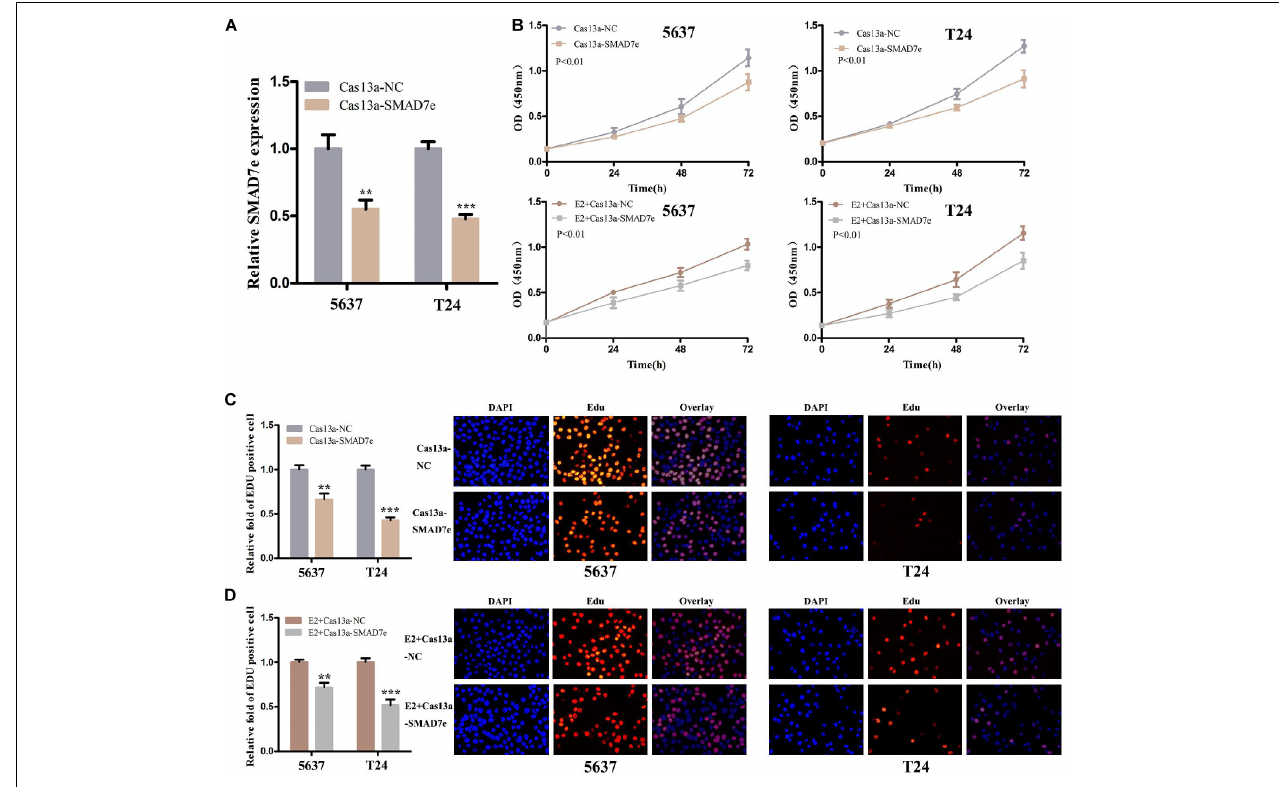
FIGURE 3 | The effect of Cas13a-SMAD7e on the proliferation of E2-treated bladder cancer cells. (A) SMAD7e expression levels were dramatically downregulated by Cas13a-SMAD7e. (B) Cell proliferation was detected by CCK8 assays in T24 and 5637 cells after transfection for 24 h. Knockdown of SMAD7e by Cas13a inhibited cell growth and reduced the proliferative effects of estrogen as determined by CCK8 assays in 5637 and T24 cells. (C) Edu assays were used to measure cell proliferation. Downregulation of SMAD7e inhibited cell growth of bladder cancer cells. (D) SMAD7e knockdown reduced the pro-proliferative effects of estrogen in 5637 and T24 cells. E2 represents estrogen. Data are shown as the mean ± SD (** p < 0.01, *** p <